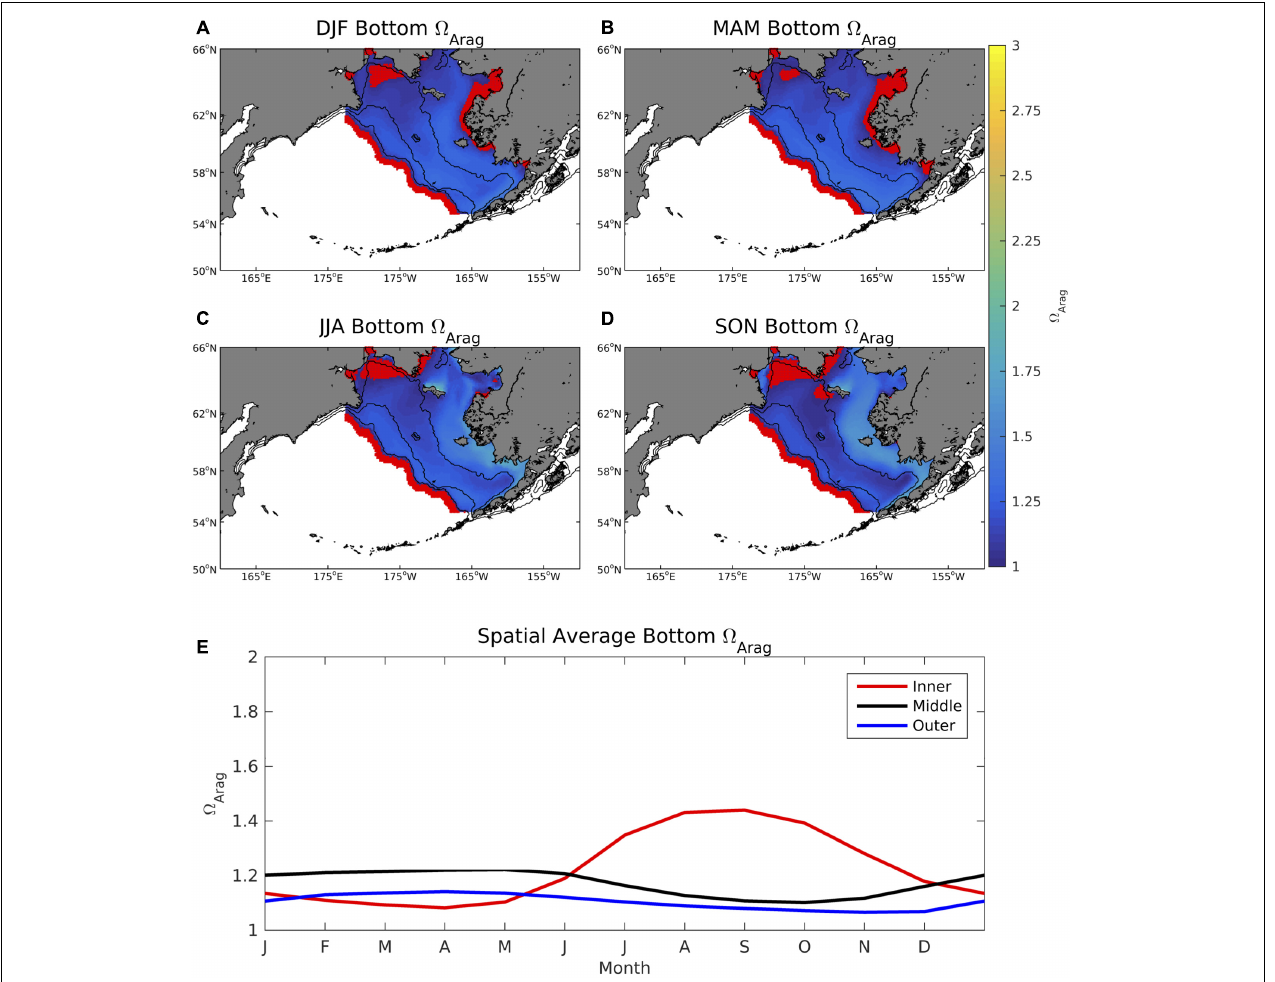
FIGURE 7 | (A–D) Seasonal plots of model bottom water (cid:127) Arag averaged over the 2003–2012 timeframe and (E) time series of area-weighted spatial mean bottom (cid:127) Arag for the three shelf domains. The red dots signify locations where (cid:127) Arag < 1. Regions deeper than the Bering Sea coastal shelf break ( > 1500 m) are whited